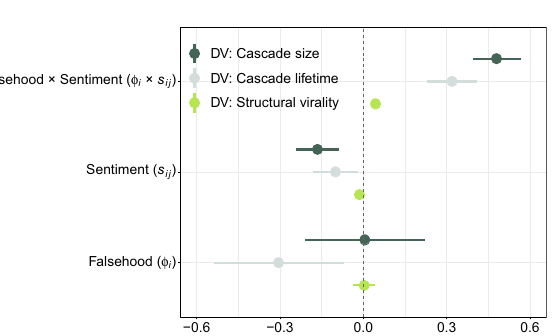
Figure 4. Complementary cumulative distribution functions (CCDFs) for conveyed emotions. Statistical comparisons are based on a Kolmogorov–Smirnov (KS) test.